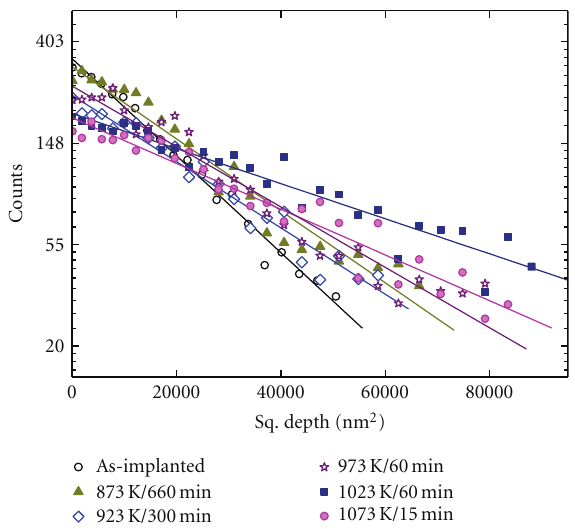
Figure 6: Penetration profiles of the silicon obtained after annealing the independently implanted samples at di ff erent temperatures in D9 steel.